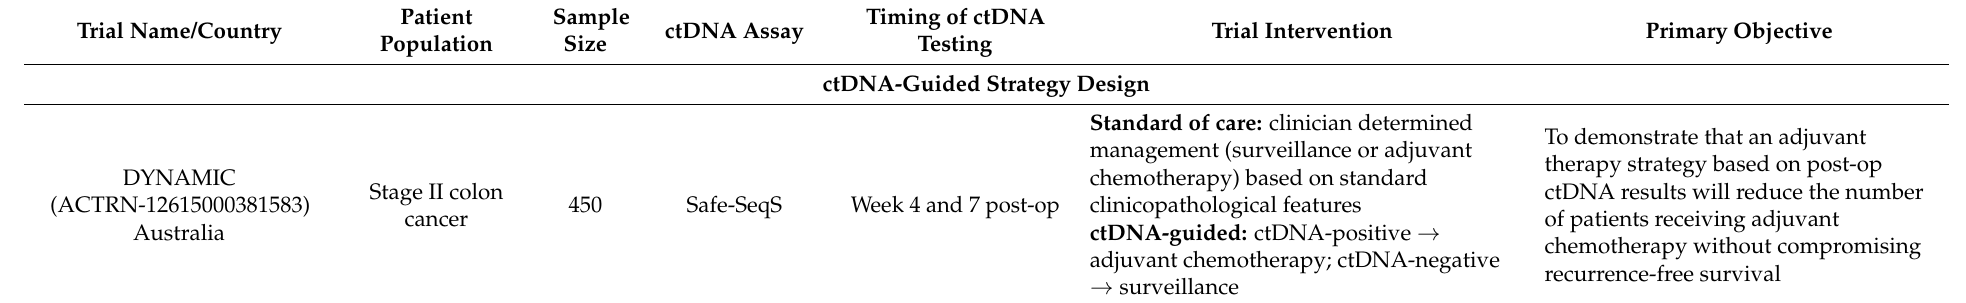
Table 2. Ongoing ctDNA-based randomised adjuvant trials in non-metastatic colorectal